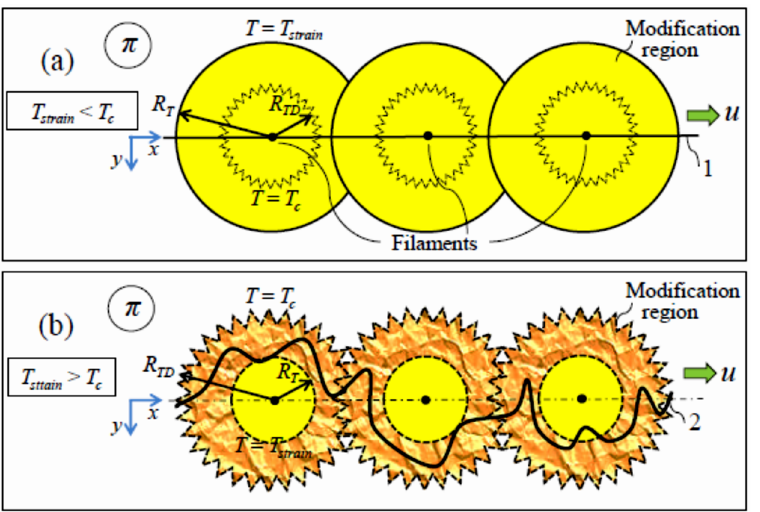
Figure 6. ( a ) Obtaining, or ( b ) not obtaining a smooth separation, depending on the dominance of one or another material modification mechanism: ( a ) The dominance of the thermal mechanism of formation of the impact zone, i.e., R T > R TD , where R T is the radius of the cylindrical impact zone around the filament axis due to the thermal mechanism, and R TD is the similar radius of the impact zone due to the thermal deformation mechanism, with the radius of the filament being r f << R T , R TD . π is the indicated in Figure 3A plane of the cross-section of impact zones of the filament, which are sequentially generated by moving the laser beam relative to the material, u is the speed and direction of relative movement of the laser beam and material. T = T strain and T = T c are the positions of the corresponding isotherms in the material that determine the boundaries of the modification zones for these mechanisms. 1 is a straight and smooth line of material separation during its subsequent mechanical splitting in this case. ( b ) The dominance of the thermal deformation mechanism when R TD > R T . As can be seen, at radii r such that R T < r ≤ R TD , there is a characteristic area of damage and cracking of the material as a result of irradiation. 2 is a zigzag-like line (surface) of separation, randomly changing direction, obtained in this case by mechanical splitting after irradiation since it passes along random microcracks and boundaries between pieces of material formed as a result of cracking in the indicated damage area of the material. Such a surface 2 corresponds to a rough, non-smooth separation of the